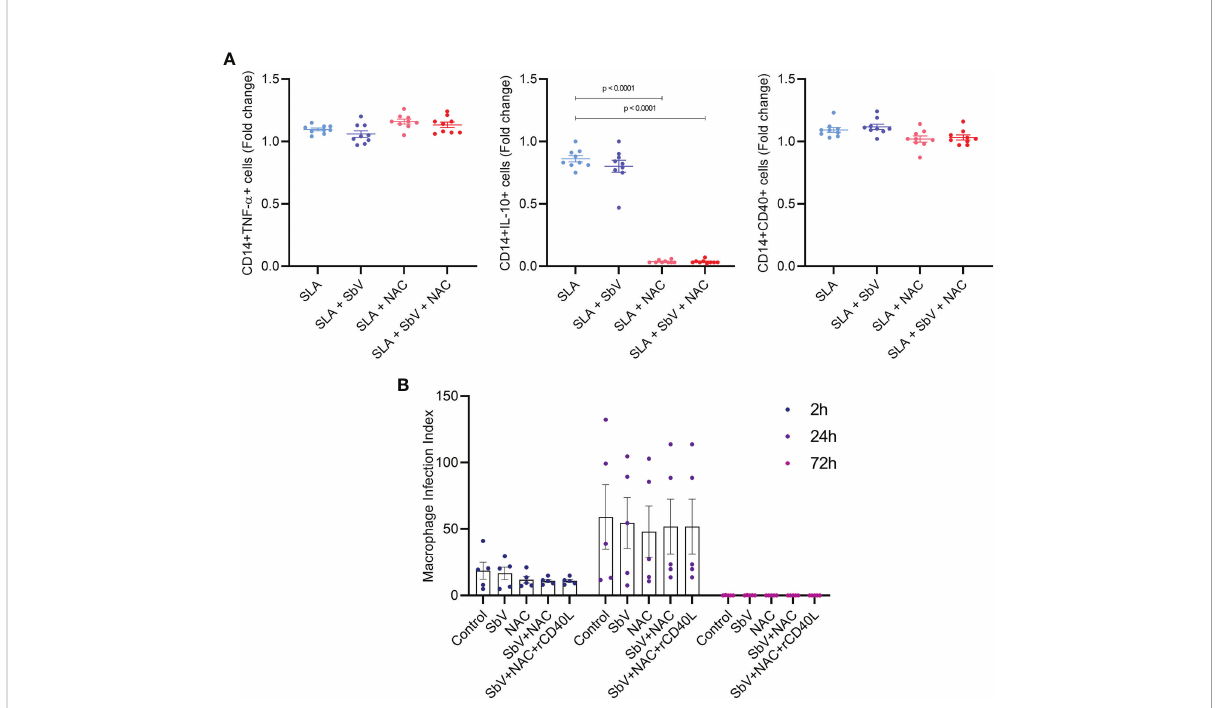
FIGURE 4 (A) Frequency of CD14+ monocytes producing TNF- a , IL-10+, CD40+ in PBMCs stimulated with SLA and treated or not with SbV, NAC, and SbV + NAC and obtained by fl ow cytometry. Graphs represent a fold change from unstimulated cells. Dots represent each healthy donor (n = 9), and lines represent mean ± SEM. (B) Macrophage infection index obtained from counting macrophages differentiated from PBMC and infected with L. infantum isolate (n = 5, in duplicate). Friedman test followed by Dunn ’ s test was used for